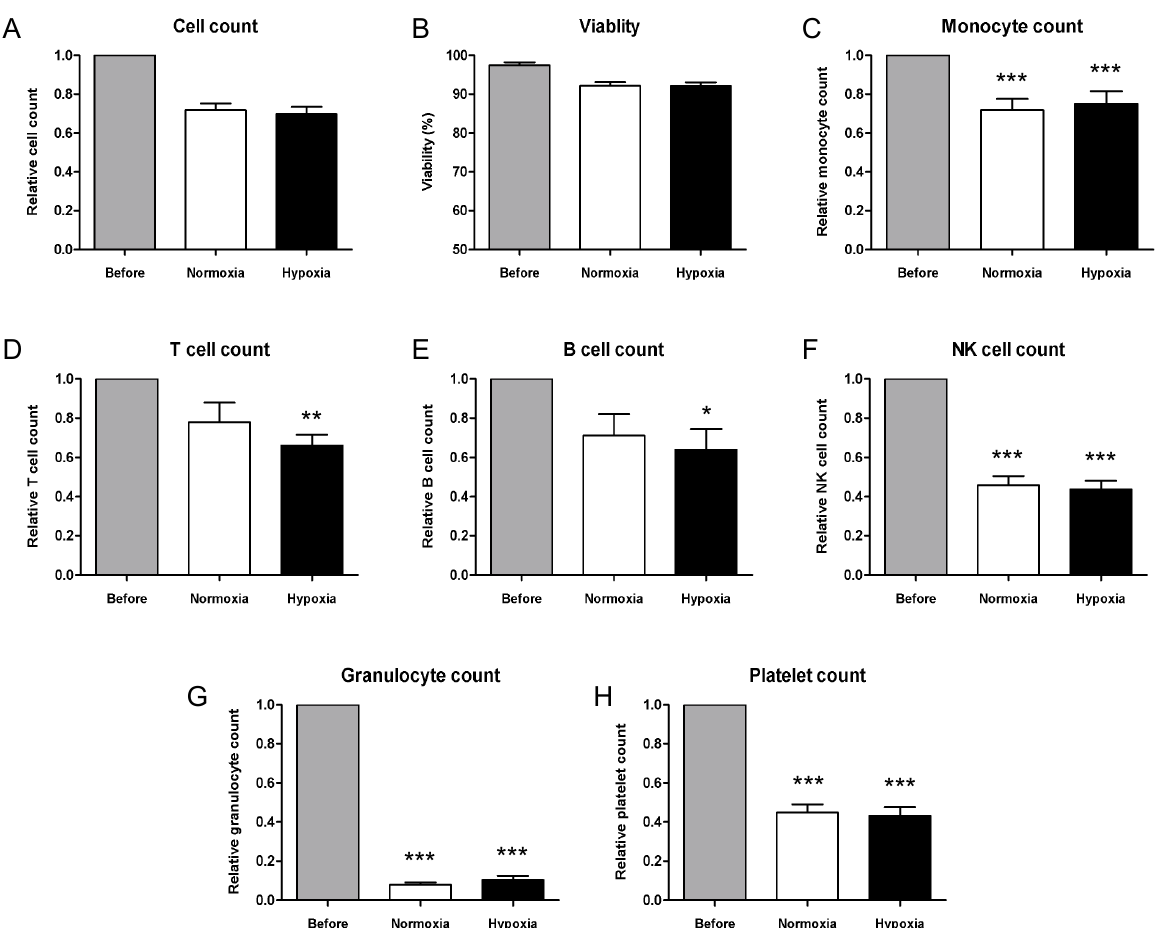
Figure 2. Immunophenotyping and quantification of PBMC before conditioning and after a 24 h culture in normoxic (5% CO2, 95% air) and hypoxic (5% CO2, 2% O2, 93% N2) environments. ( A ) Relative cell count, ( B ) viability percentage and relative count of ( C ) monocytes, ( D ) T cells, ( E ) B cells, ( F ) NK cells, ( G ) granulocytes and ( H ) platelets. Relative cell count is normalized to PBMC number before conditioning. Data are represented as mean ±SEM on N = 15 samples. Statistically significant differences were observed between normoxia or hypoxia compared to control (Before). * = p < 0.05, ** = p < 0.01, *** = p < 0.001.